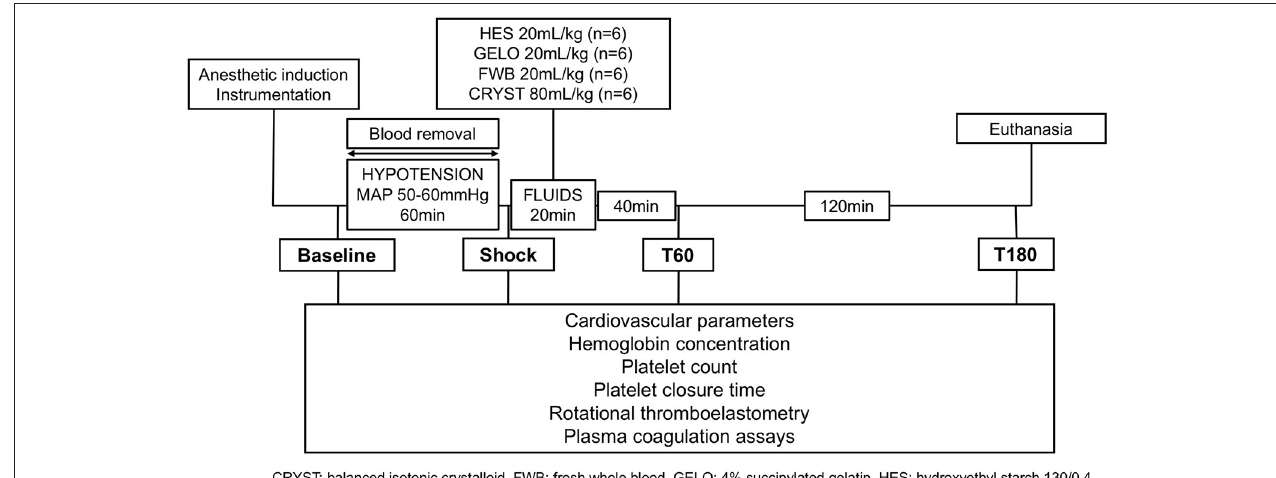
FIGURE 1 | Summary of experimental